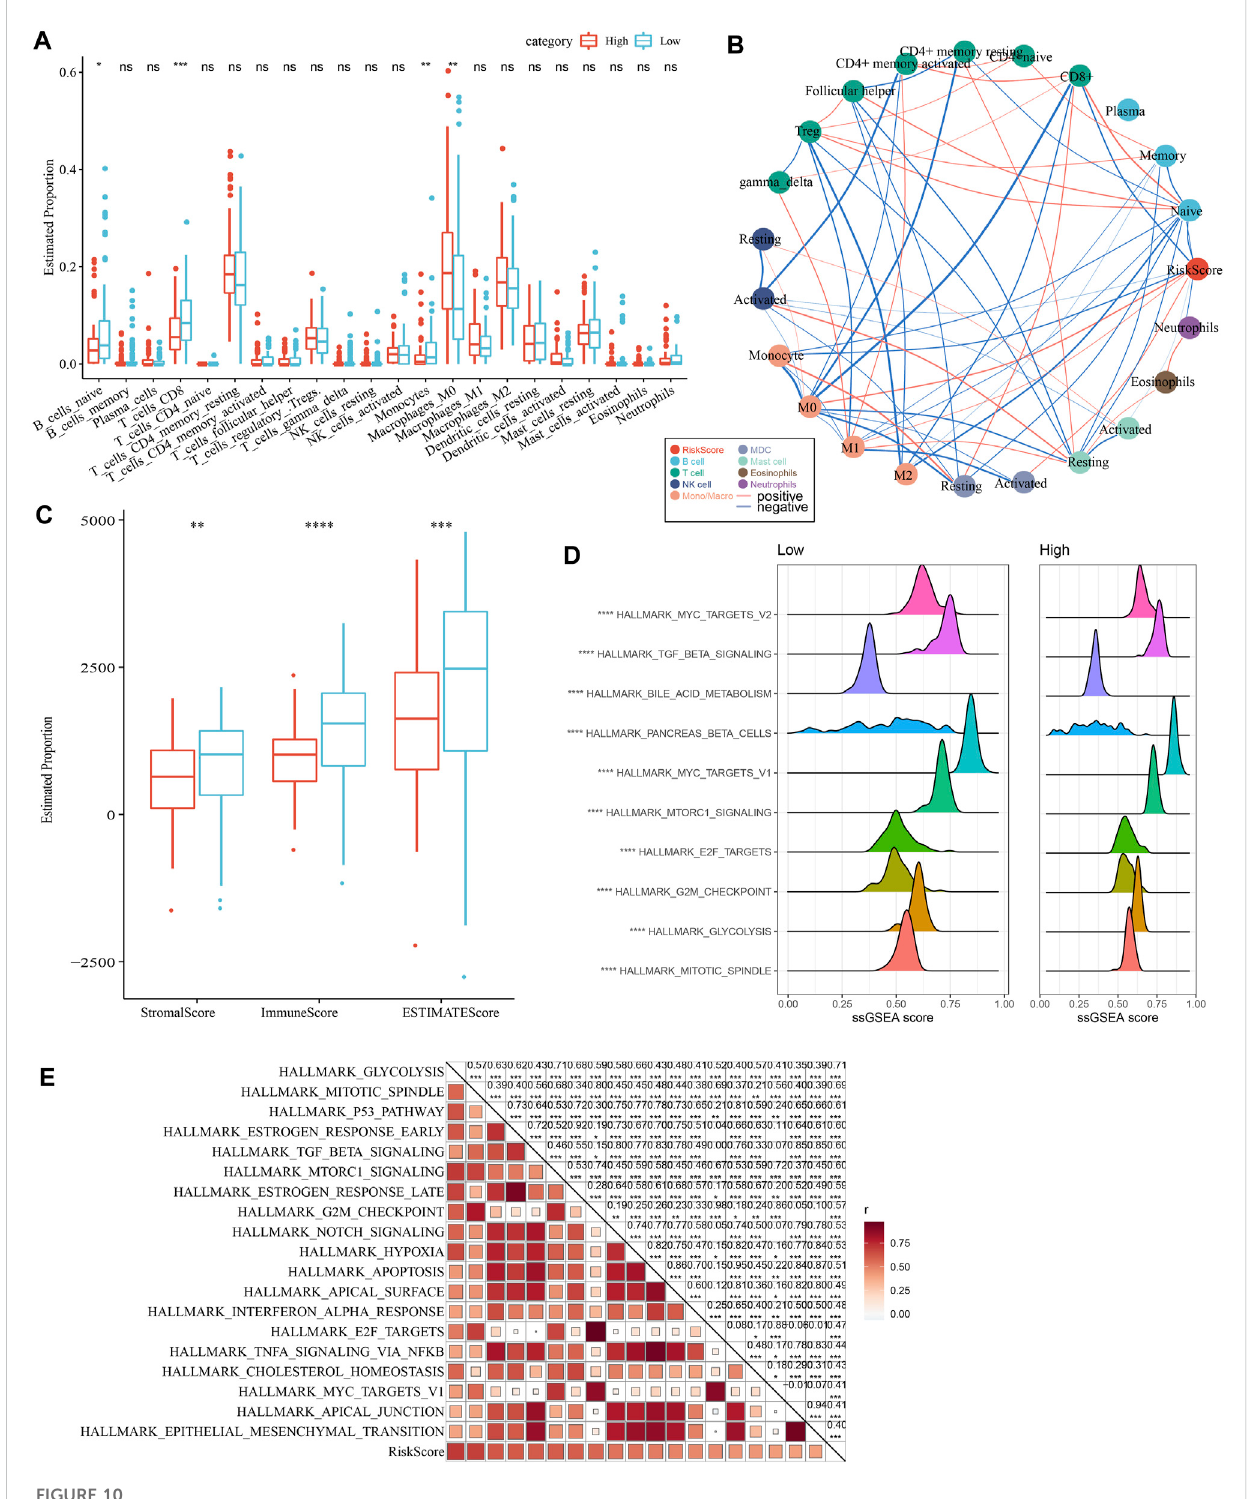
FIGURE 10 Comparison of immune in fi ltration and pathways between two risk groups. (A) Comparison of the proportion of immune cells in the TCGA cohort; (B) Correlationanalysisbetween22immunecellsandriskscoreintheTCGAcohort; (C) ComparisonoftheresultsofESTIMATEbetweentworiskgroups; (D) The top 10 pathway with the most signi fi cant difference between the two risk groups. (E) Correlation analysis between pathways and risk